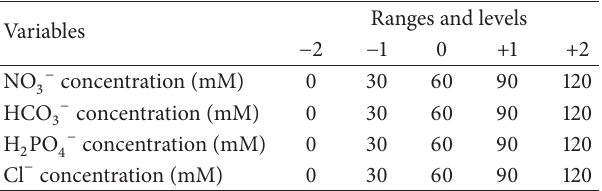
Table 2: Experimental ranges and levels of the independent test variables.